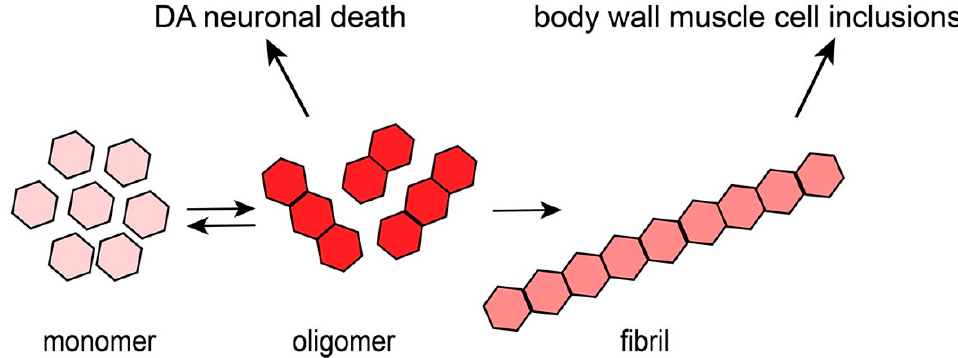
Figure 1. The process of α -syn oligomerization and fibrilization. Monomers of α -syn are small, soluble and have the capacity to associate together and oligomerize. These soluble oligomers are thought to be cytotoxic and act as the major contributor to neurodegeneration and neuronal deficits. Over time, oligomers have the potential to fold into β -sheet-containing fibrils, which constitute Lewy Bodies in PD.